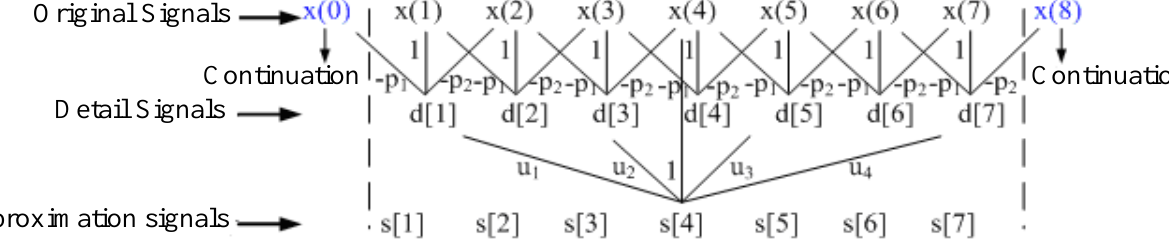
Figure 3. The reconstruction process of redundant second generation